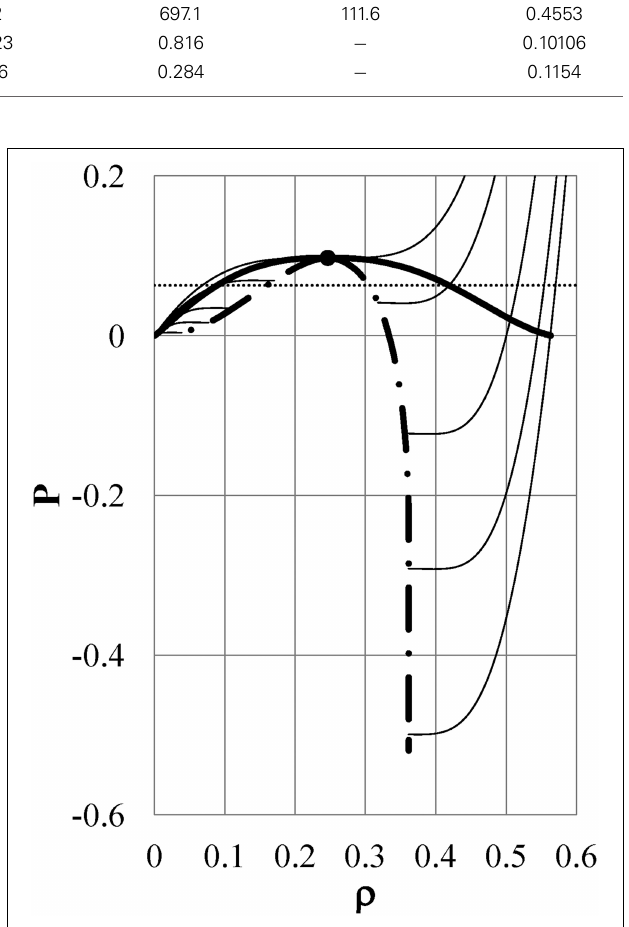
FIGURE 2 | Pressure isotherms of Model φ 2 in the P - ρ plane: Thin full lines: pressure isotherms at kT c = 1 . 235, kT 1 = 1 . 135, kT 2 = 0 . 925, kT 3 = 0 . 735, and kT 4 = 0 . 543 from the top to the bottom of the figure, respectively. Thick full line: binodal curve, which has a critical point (full circle) of ( ρ c , P c ) = (0.2464, 0.0974) and a maximum density ρ = 0.5633. Dot-dash line: spinodal curve, which has the largest density ρ = 0 . 3615, and a minimum pressure P = − 0 . 5196. Dotted line: P = 0 .